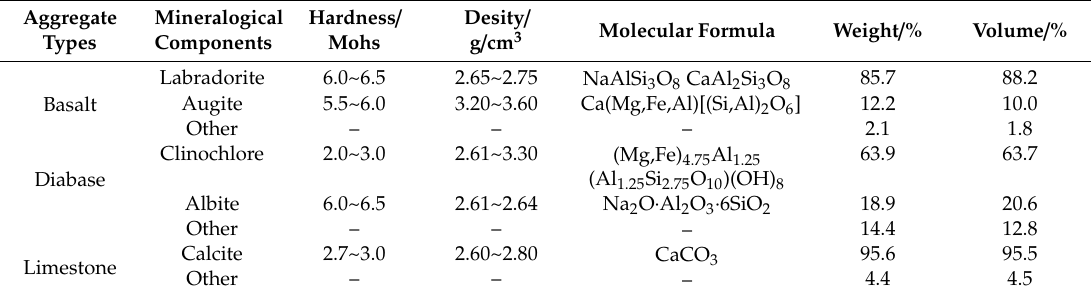
Figure 1. Intensity of mineralogical components of aggregates. ( a ) Basalt aggregates (BA), ( b ) diabase aggregates (DA) and ( c ) limestone aggregates (LA). Table 2. Mineralogical components of different lithological aggregates